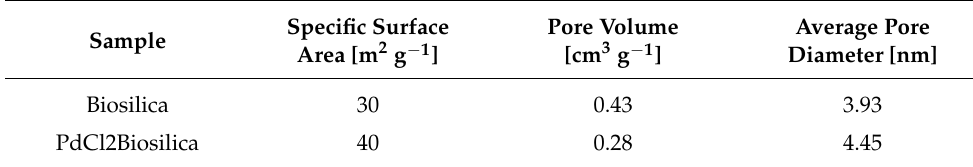
Table 1. Porous structure parameters of the samples studied.